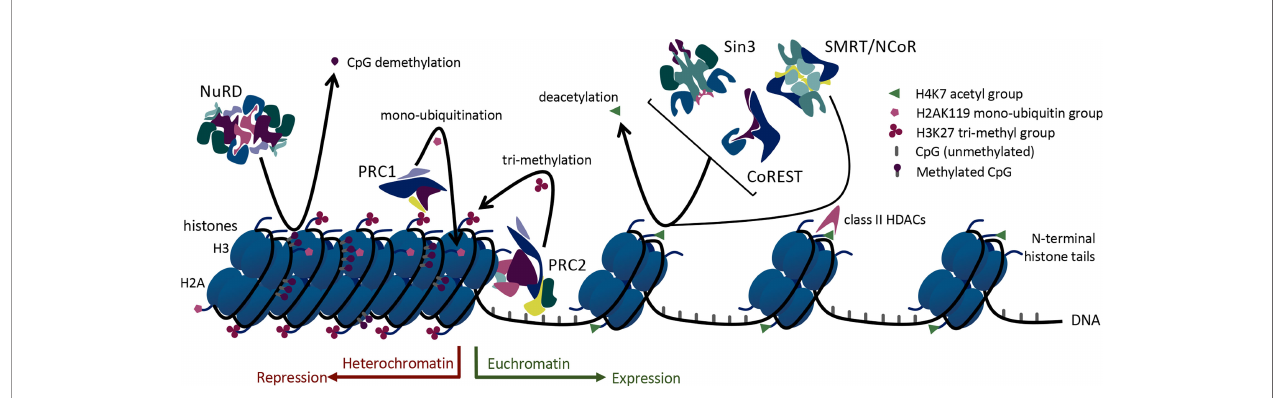
FIGURE 1 | Mechanisms of epigenetic regulation utilized by large multiprotein complexes in Treg